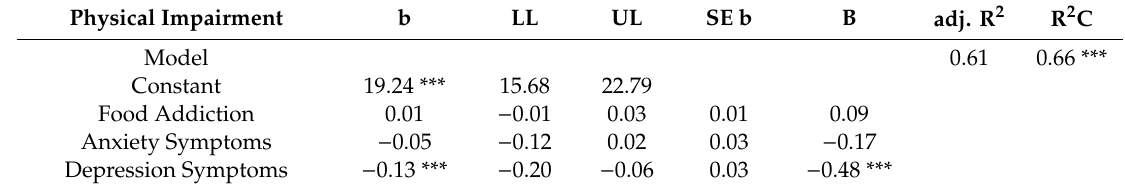
Table 4. Multiple regression results predicting physical impairments measured using